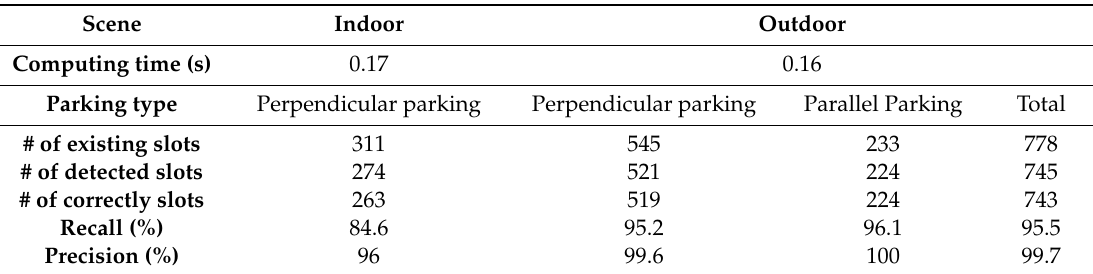
Table 5. Indoor and outdoor parking space detection rates.